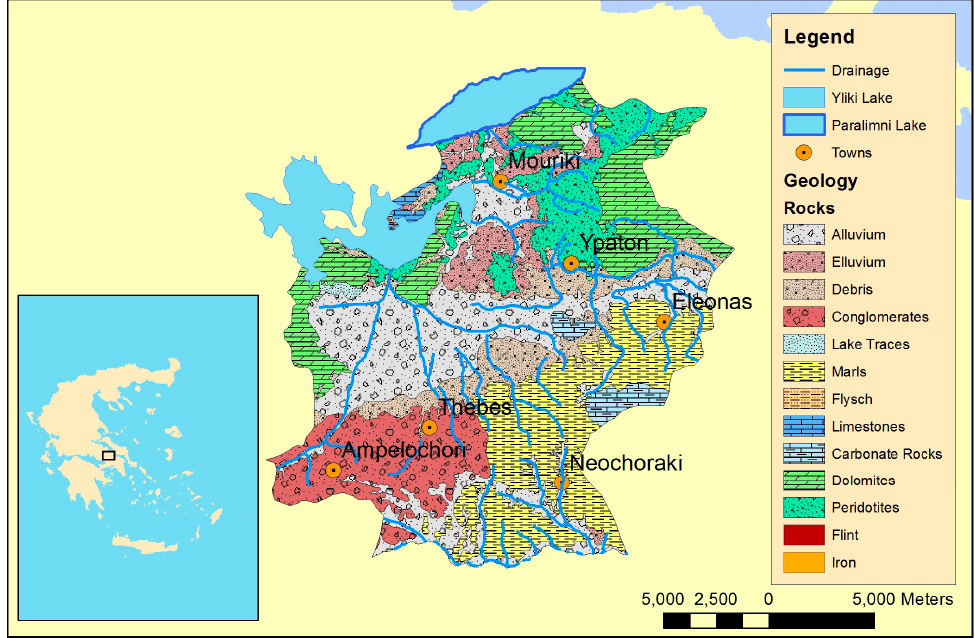
Figure 1. Geological map of the study area.